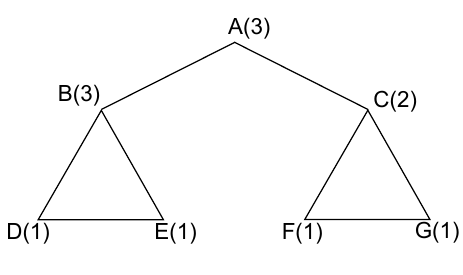
Figure 2. One example of a coding